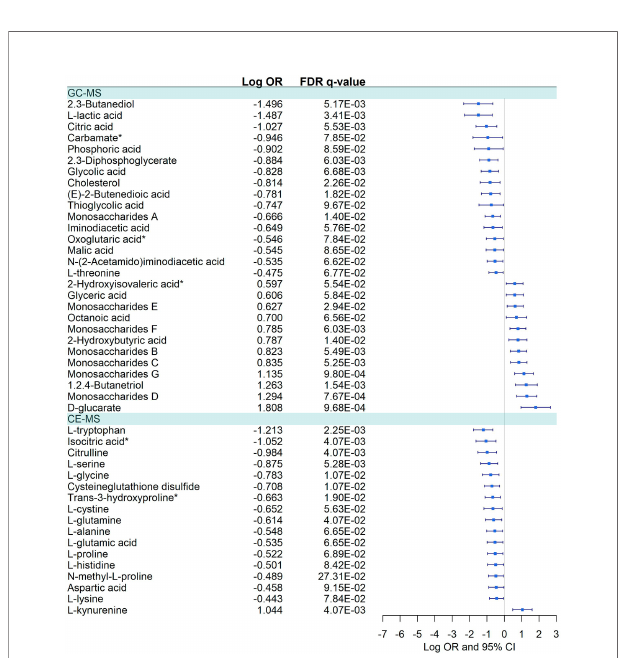
FIGURE 6 | Pairwise comparisons between Severe vs. Moderate patients in GC-MS and CE-MS metabolites. Multivariate logistic regression, adjusted for age and sex, was used to compare severe vs. moderate patients. The False Discovery Rate or FDR was used to cope with multiple testing, q- values are provided. Carbamate*: Tris(trimethylsilyl)carbamate. Oxoglutaric acid*, Alpha-ketoglutaric acid. 2-Hydroxyisovaleric acid*, 2-Hydroxy-3- methylbutyric acid/Pentanoic acid 2-[(trimethylsilyl)oxy]-, trimethylsilyl ester. Trans-3-hydroxyproline*, trans-3-hydroxyproline/trans-4-hydroxyproline/cis- 4-Hydroxy-D-proline. Isocitric Acid*, Citric Acid/Isocitric acid. D-Alanyl-D- Valine*,